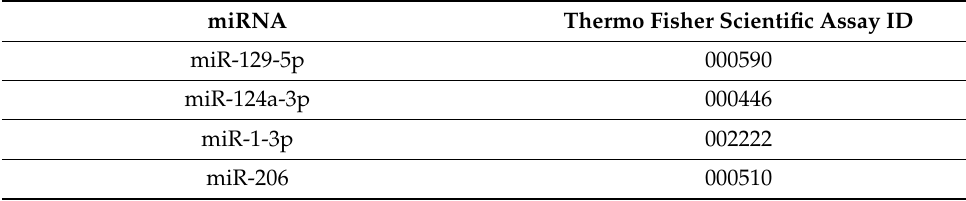
Table 3. TaqMan RT-PCR probe and primer assay ID for miRNA quantification.